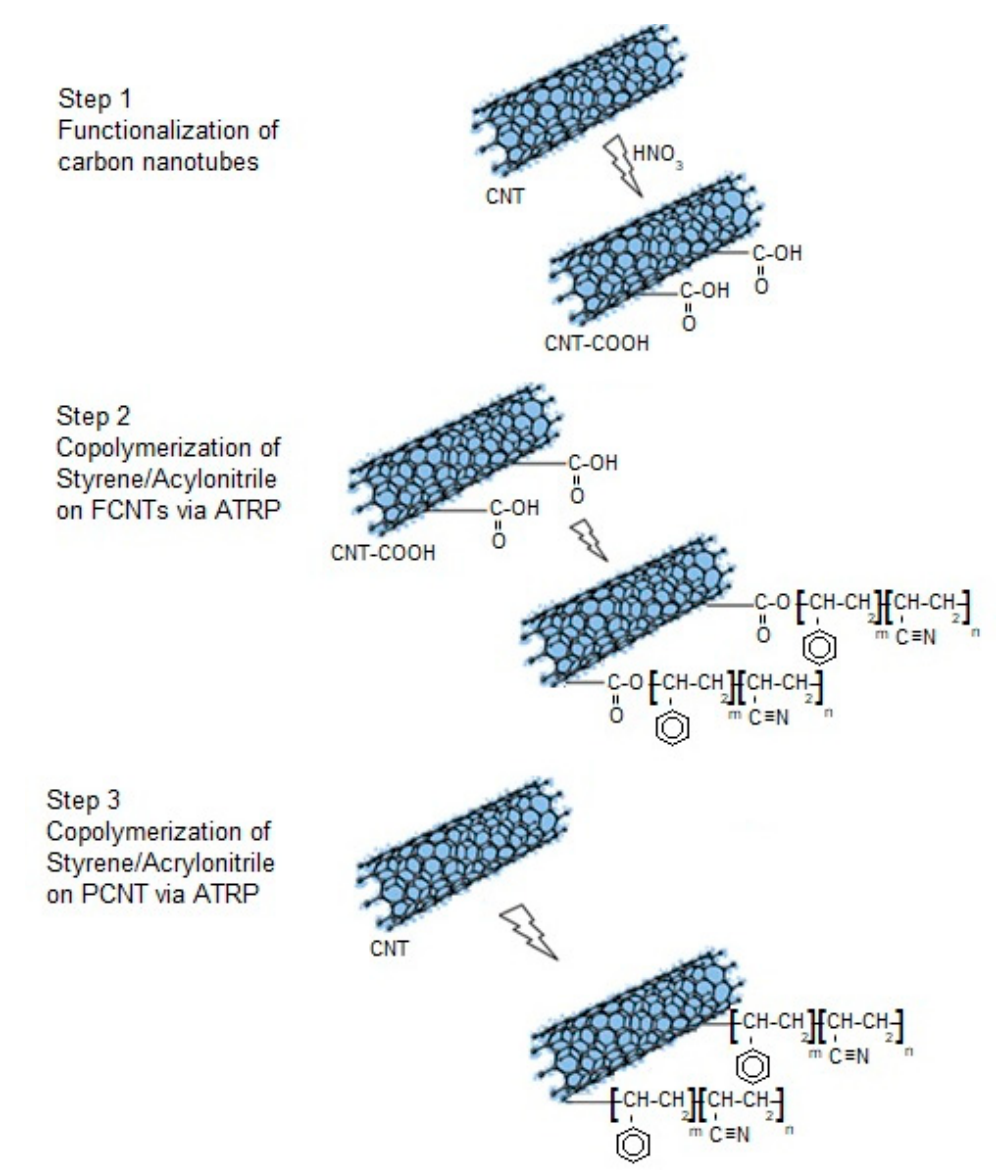
Figure 2. Schematic representation of functionalization CNT and synthesis of pristine CNT (PCNT) and acid-functionalized (FCNT).